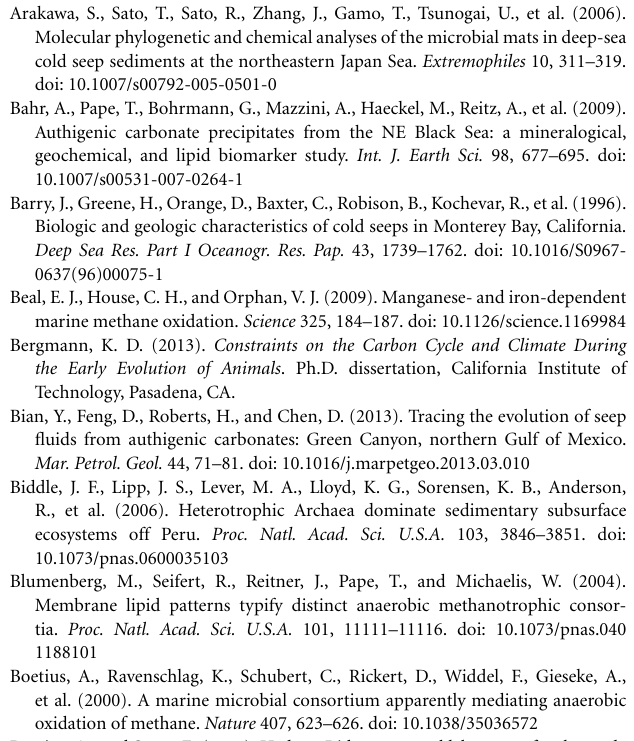
Figure S1 | X-ray diffraction data from the 12 samples analyzed in this study. Each panel shows an experimental spectrum and peak placements of the top database matches. Qualitative mineralogical assignments based on relative peak heights are provided below the sample identifier. Figure S2 | Bacterial Chao-1 (blue) and Inverse Simpson (red) values vs. archaeal Chao-1 and Inverse Simpson values. The wide scatter of both blue and red points suggests no significant correlation between domain-level diversity indices. R 2 of the linear best fit is 2 . 8 × 10 − 5 for Chao-1 and 0.029 for Inverse Simpson. Figure S3 | Non-metric MDS results of (A) archaeal and (B) communities, where samples are labeled by mineralogical